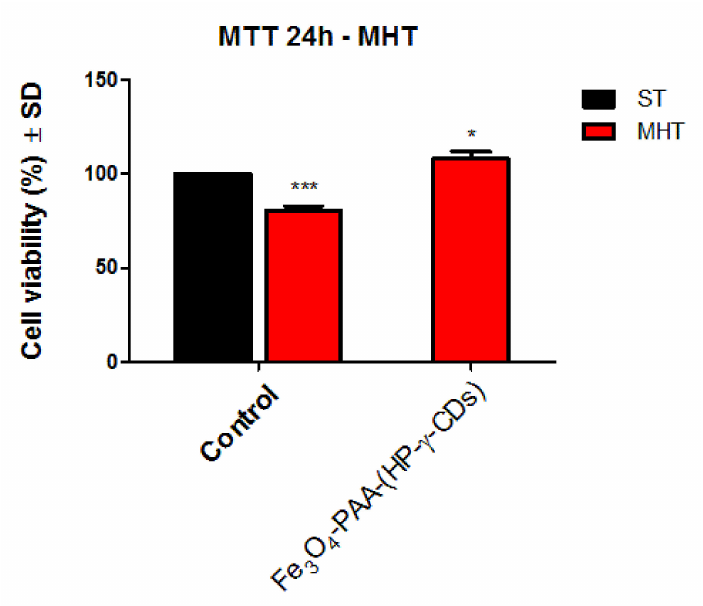
Figure 16. Cell viability percentage of HaCaT cells maintained under standard (ST) and magnetic hyperthermia (MHT) parameters or treated with 10,000 µ g/mL of Fe 3 O 4 -PAA–(HP- γ -CDs) under MHT conditions. Data are presented as the percentage of the viable cell population under MHT (stimulated or unstimulated with test sample) normalized to the cell viability rate of the control cells (cells treated with culture medium and maintained under standard conditions at 37 ◦ C) ± standard deviation (SD). One-way ANOVA analysis was applied to determine the statistical differences between MHT-treated cells and control cells, followed by Dunnett’s post-test (* p < 0.05; *** p < 0.001 versus